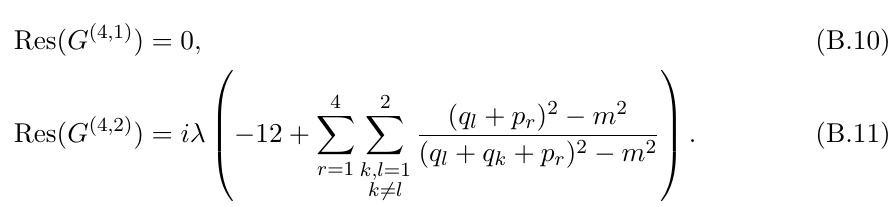
Figure 4 . Relevant diagrams for the computation of G (4 ; 1) and G (4 ; 2) in the (cid:30) 4 theory with (cid:18) insertions at tree level. Empty (solid) dots denote the sources for (cid:30) ( (cid:18) ). where all momenta are taken as ingoing. Using equations (B.4){(B.9) we